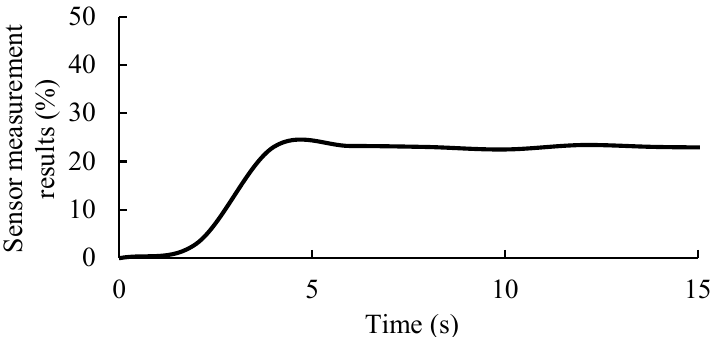
Figure 10. EEMFI sensor dynamic characteristic curve. Table 6. EEMFI sensor dynamic characteristics index.